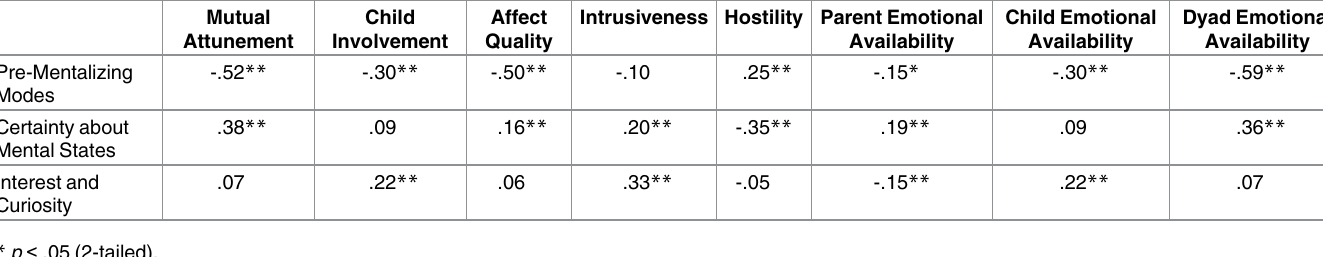
Table 4. Correlations among the PRFQ subscales and emotional availability in Study